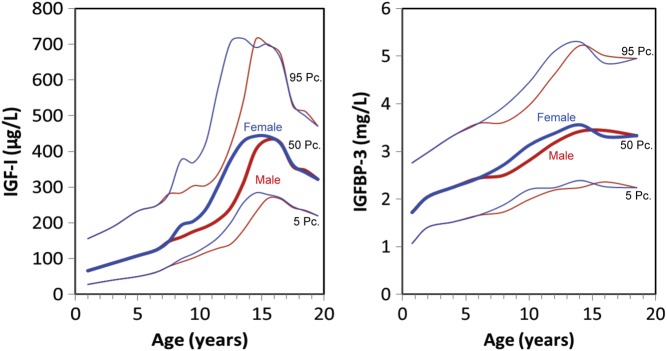
Normal ranges of serum IGF-I and IGFBP-3 in children and interpretation of serum IGF-I and IGFBP-3 levels. Drawn from data reported in Blum WF, Böttcher C, Wudy SA. Insulin-like growth factors and their binding proteins. In: Diagnostics of Endocrine Function in Children and Adolescents, ed. 4, pp 157–182. Eds Ranke MB, Mullis P-E. S Karger, Basel, 2011 (61). IGF, insulin-like growth factor; IGFBP, IGF-binding protein.